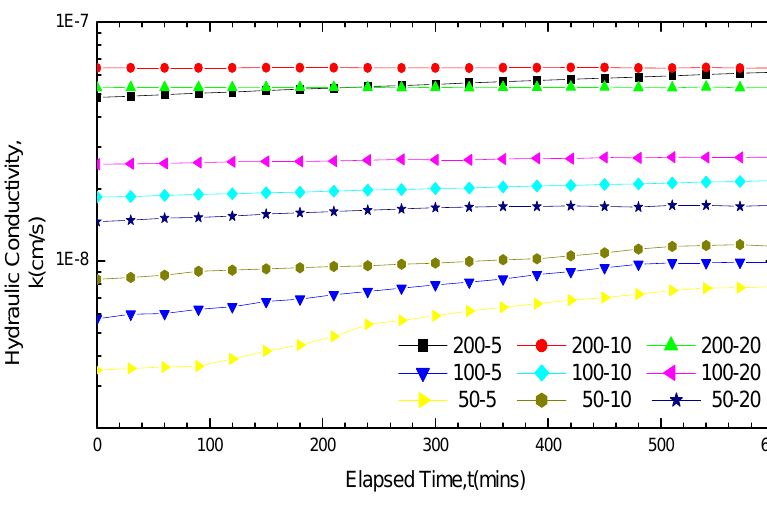
Figure 7. Hydraulic conductivity results for GCL specimens soaked and permeated with NaCl